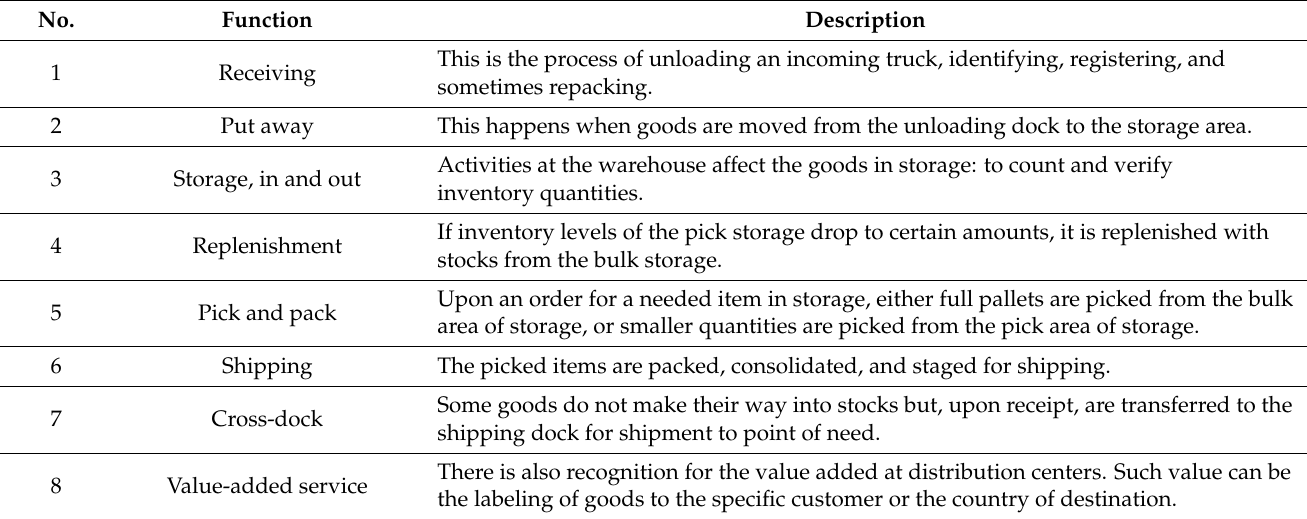
Table 1. Picking and materials handling in the warehouse facility